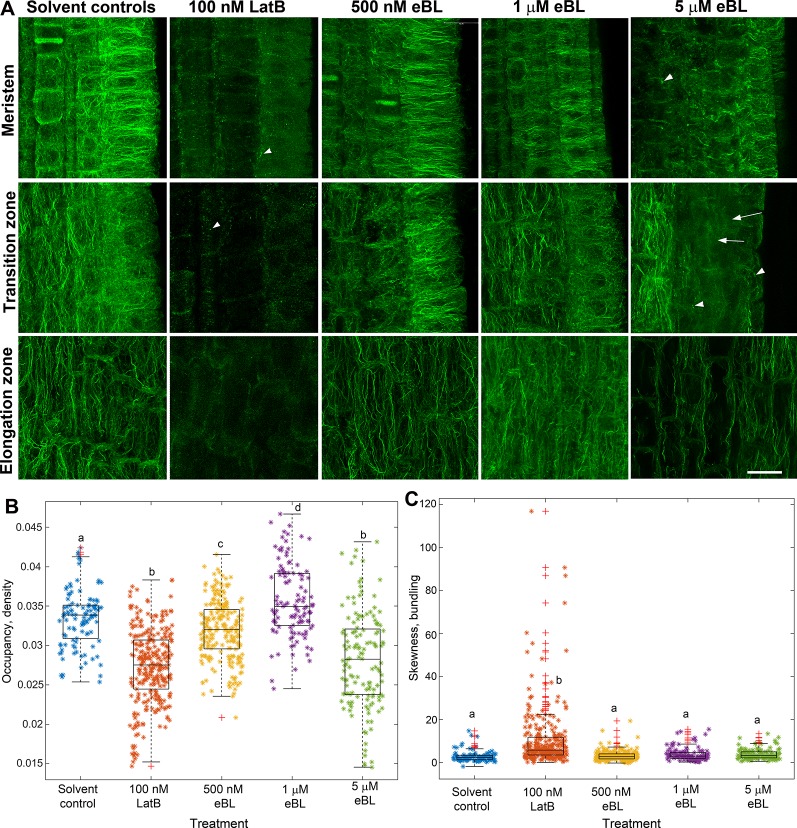
Epi-Brassinolide (eBL) modified F-actin organization in Z. mays roots. (A) Single optical confocal micrographs of chemically-fixed and longitudinally-sectioned Z. mays roots stained with Alexa Fluor 488-phalloidin. Note that LatB-treated roots had diffuse staining and fragmentation of F-actin in the form of puncta and short filaments (arrowheads). Untreated (solvent controls) had extensive F-actin networks. 500 nM and 1 µM eBL on the other hand did not result in any visible effects on F-actin. At 5 µM eBL, some regions of the meristem, transition and elongation zone have diffuse fluorescence (arrows) and fragmented F-actin (arrowheads). (B, C) Combined box and scatter plots showing quantitative analysis of F-actin occupancy (density B) and skewness (bundling C) in root cells of the transition/elongation zone. Statistical significance was determined by one-way ANOVA. Asterisks (*) refers to individual data points and + mark outliers. Bars are means (n > 100 cells) ± S.E. Different letters indicate significant differences among means (P < 0.05, Tukey’s test). Scale bars = 20 μm.